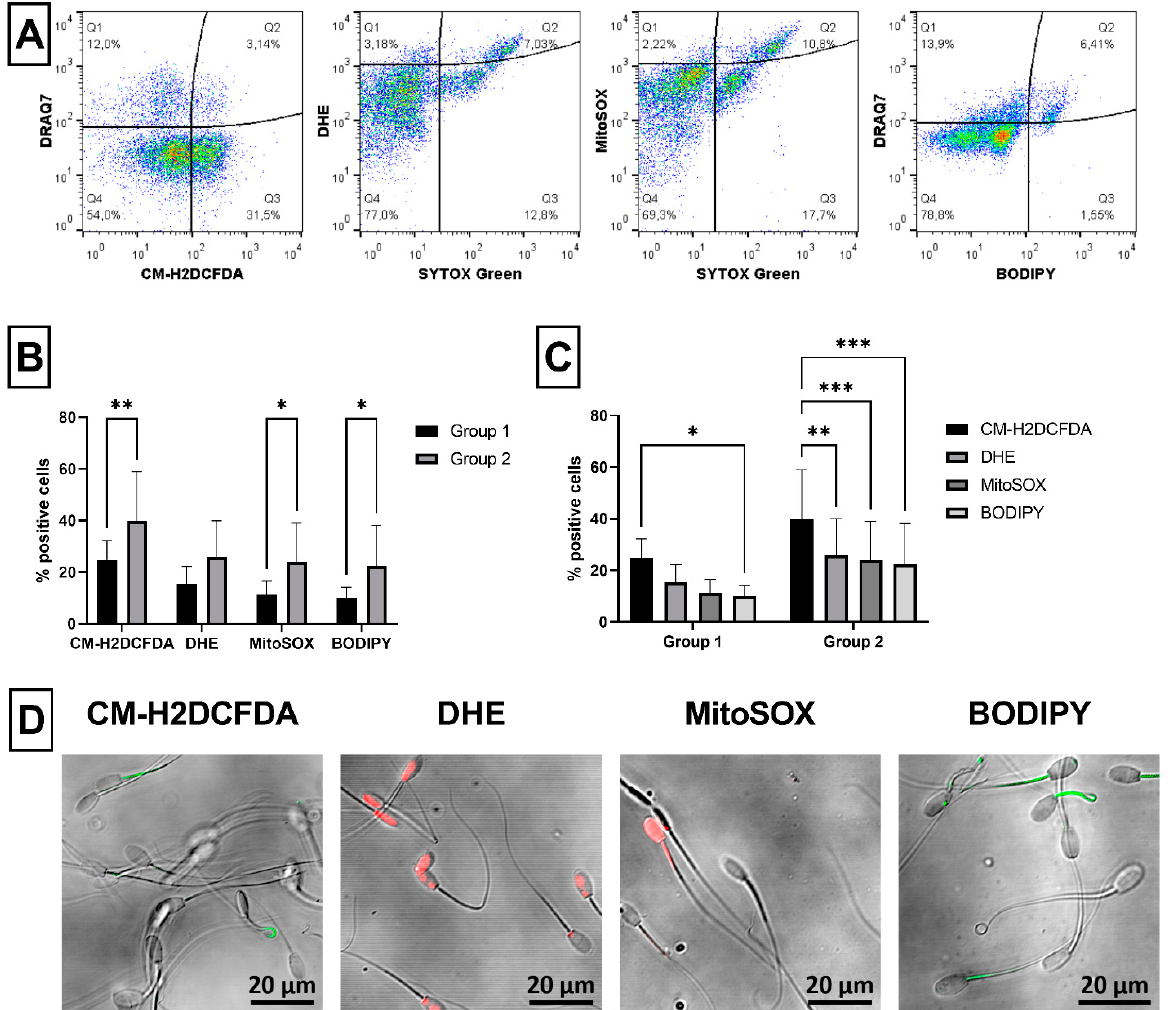
Figure 5. Evaluation of ROS generation in ram semen samples. Illustrative flow-cytometric dot plots showing evaluation strategy of analyzed fluorescent probes. Spermatozoa gated using FSC/SSC dot plot showing dead spermatozoa in far-red FL4 channel (DRAQ7 + ) or green FL1 channel (SYTOX Green) and ROS positive spermatozoa in green FL1 channel (CM-H 2 DCFDA and BODIPY) or red FL3 channel (DHE and MitoSOX) were divided into four quadrants (Q) according to fluorescent signals ( A ). Graph showing comparison of ROS positive spermatozoa detected using CM-H 2 DCFDA (Q2: CM-H 2 DCFDA + /DRAQ7 + and Q3: CM-H 2 DCFDA + /DRAQ7 − ), DHE (Q1: DHE + /SYTOX Green − and Q2: DHE + /SYTOX Green + ), MitoSOX (Q1: MitoSOX + /SYTOX Green − and Q2: MitoSOX + /SYTOX Green + ) and BODIPY (Q2: BODIPY + /DRAQ7 + and Q3: BODIPY + /DRAQ7 − ) in Group 1 and Group 2 ( B ). Graph comparing proportion of ROS positive spermatozoa detected using four different fluorescent probes (CM-H 2 DCFDA, DHE, MitoSOX and BODIPY) within each group ( C ). Illustrative images from confocal microscopy (Zeiss LSM 700; magnification at 200×, scale bar = 20 µm) showing the staining pattern of ram ROS positive spermatozoa: CM-H 2 DCFDA (green), DHE and MitoSOX (red), and BODIPY (green) stained different parts (heads and tails) of spermatozoa with ROS ( D ). Group 1—semen samples with sperm viability over 60%, Group 2—semen samples with sperm viability under 60%, DHE—dihydroethidium. The data are expressed as the means ± SD; difference is statistically significant at * p < 0.05, ** p < 0.01 and *** p <